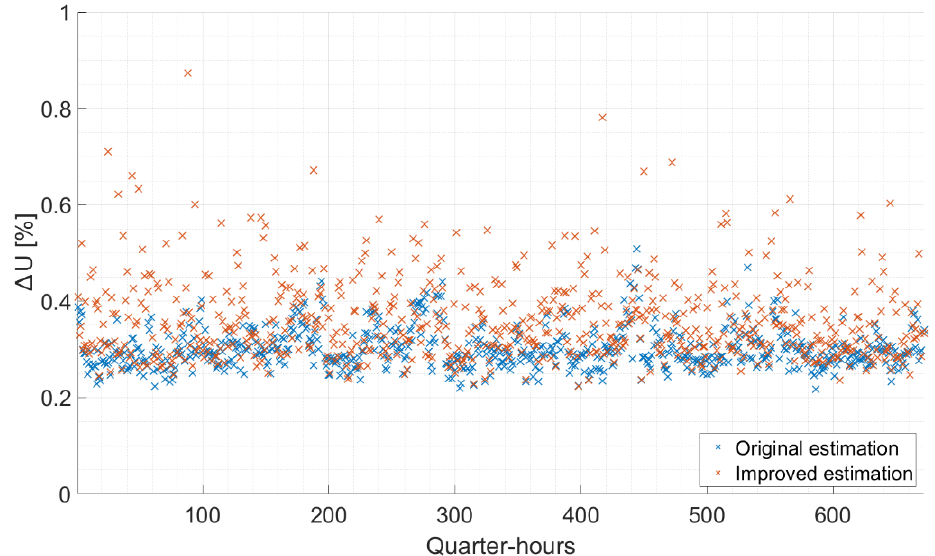
Figure 9. Temporality of the relative error of voltages for Area 20,667.